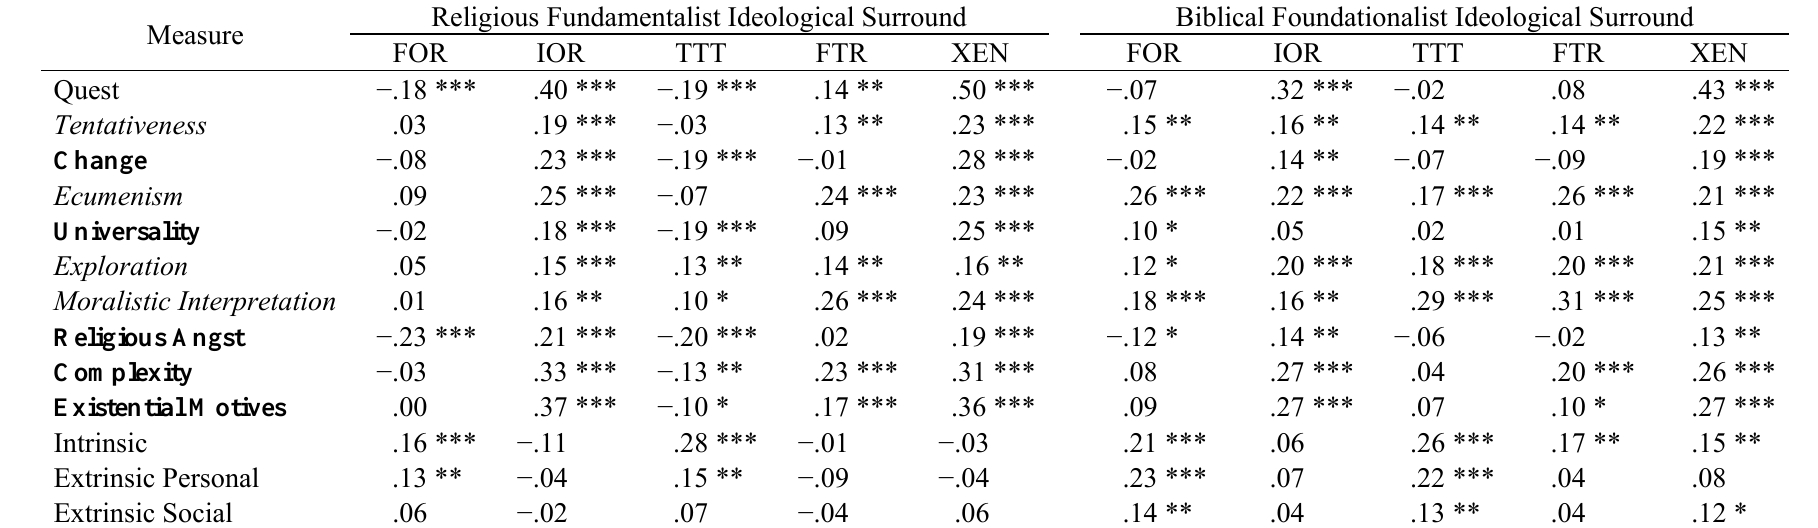
Table 5. Religious Reflection and Schema Partial Correlations with Quest and Religious Orientation Measures within Religious Fundamentalist and Biblical Foundationalist Ideological Surrounds (N=